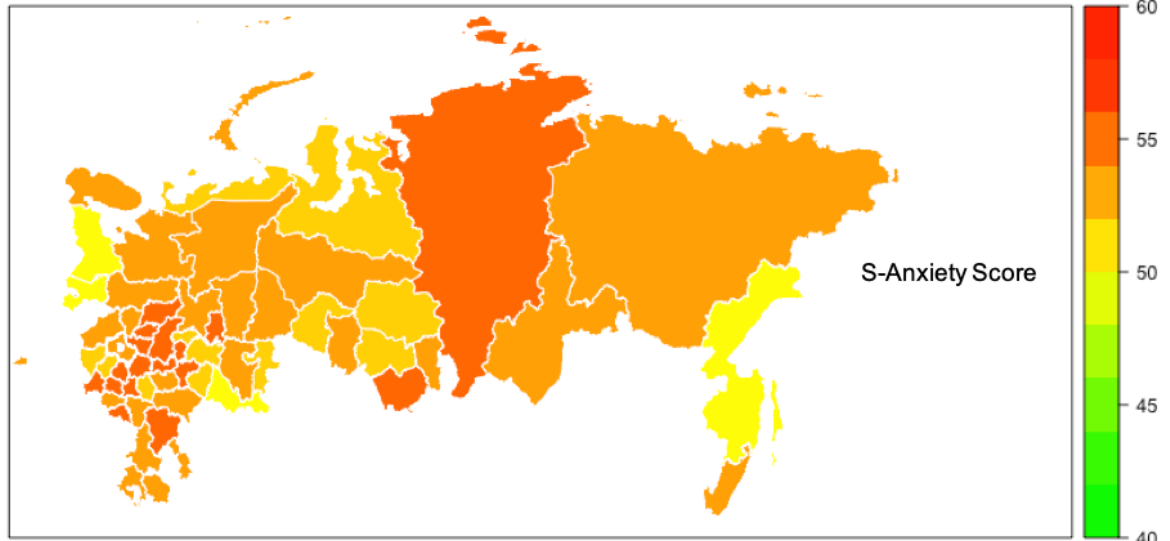
Figure 3. Map of Russia showing the levels of respondents’ state anxiety (S-Anxiety). Areas with data from less than 40 respondents are not shown on the map. S-Anxiety: State Anxiety